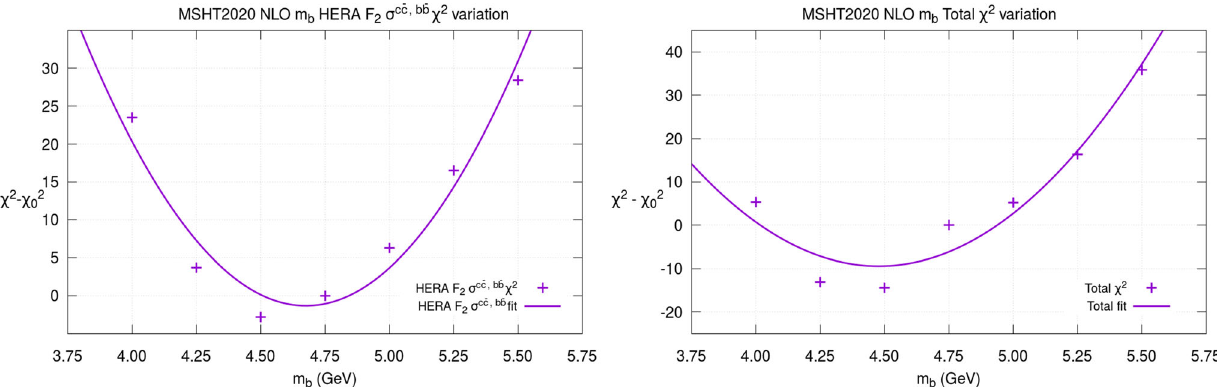
) = 0 . 118 for (left) the reduced cross section for heavy flavour Z